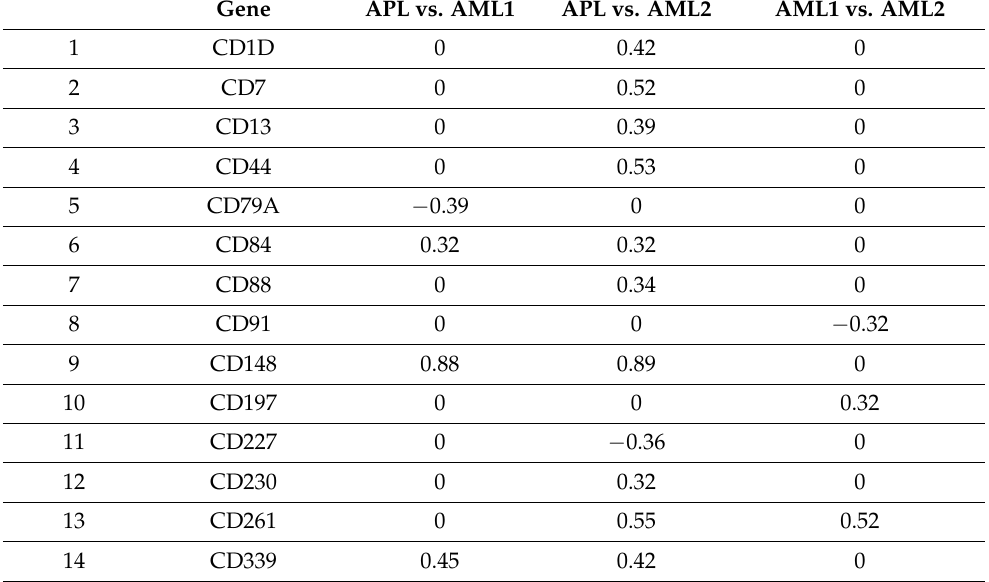
Table 3. The most important differentially expressed CD genes in AML subtypes in the RNA-Seq dataset. Cohen’s D values are indicated for each dichotomous comparison (group A vs. group B). Positive values indicate higher expression in group A. Negative values indicate higher expression in group B. Values < 0.3 were set to 0. Gene APL vs. AML1 APL vs. AML2 AML1 vs.